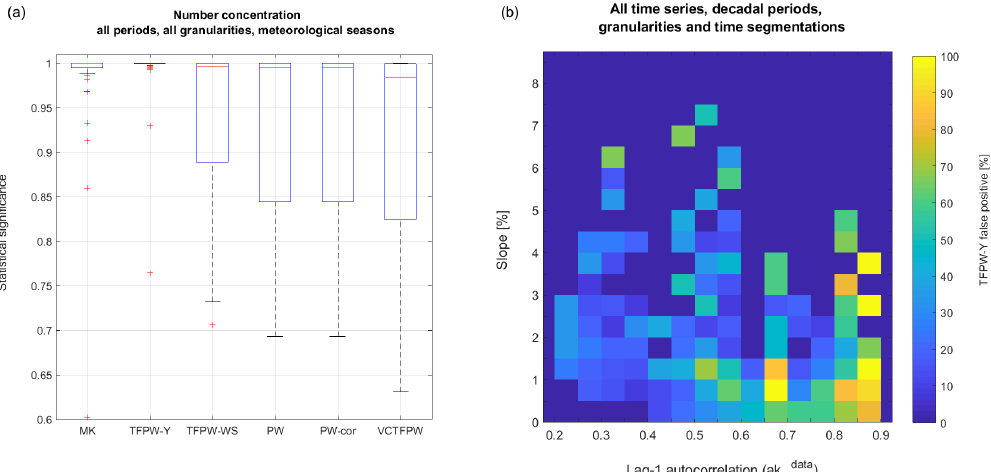
Figure 3. (a) Statistical significance of trends as a function of the prewhitening methods for the aerosol number concentration for the yearly trends computed from four meteorological seasons’ time segmentation, for all periods (5 to 24 years) and all time granularities (1d to 1 month). This represents 40 trends. The median is represented by the red line, the boxes are the 25% and 75% percentiles, the whiskers the 0.7 and 99.3 percentiles and the red plus signs the outliers. Some outliers are not in the figure for purposes of clarity. (b) Number of TFPW-Y false positives as a function of ak data and slope categories for all the computed trends of all time series for all decadal periods. Categories 1 with fewer than three points are not